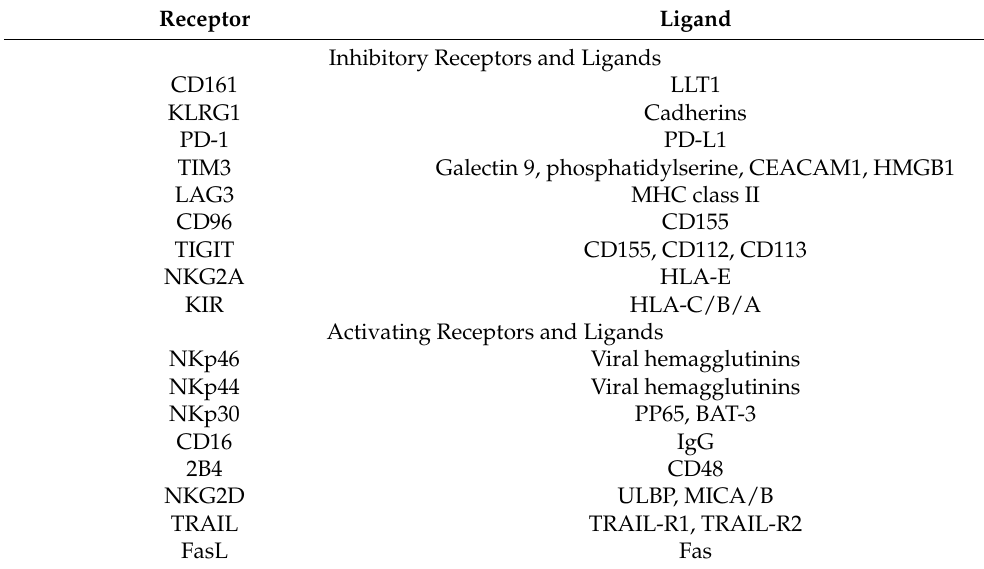
Figure 1. Activating and inhibitory NK cell receptors. Figure illustrating the panel of inhibitory and activating receptors expressed on the surface of NK cells that regulate their activation and effector function (www.biorender.com, accessed 21 December 2021). Table 1. NK cell receptors and ligands [26,34 – 39].